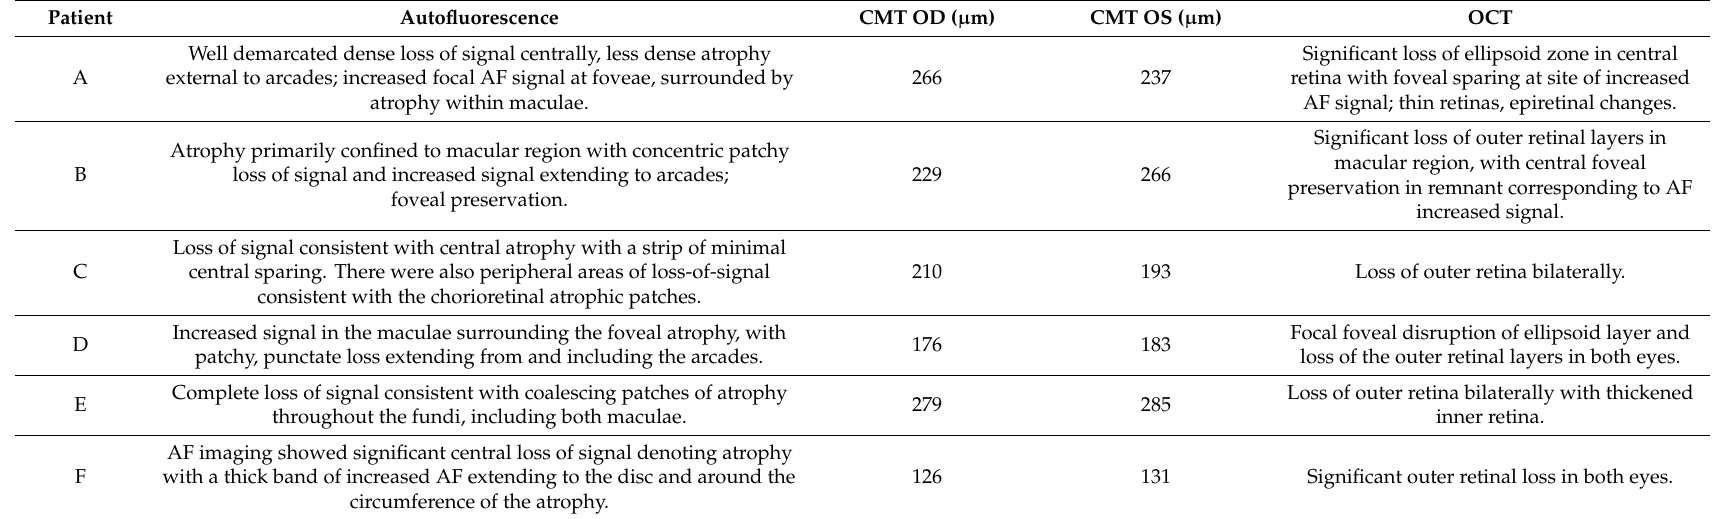
Table 3. Phenotypic features observed on autofluorescence and optical coherence tomography imaging in patients